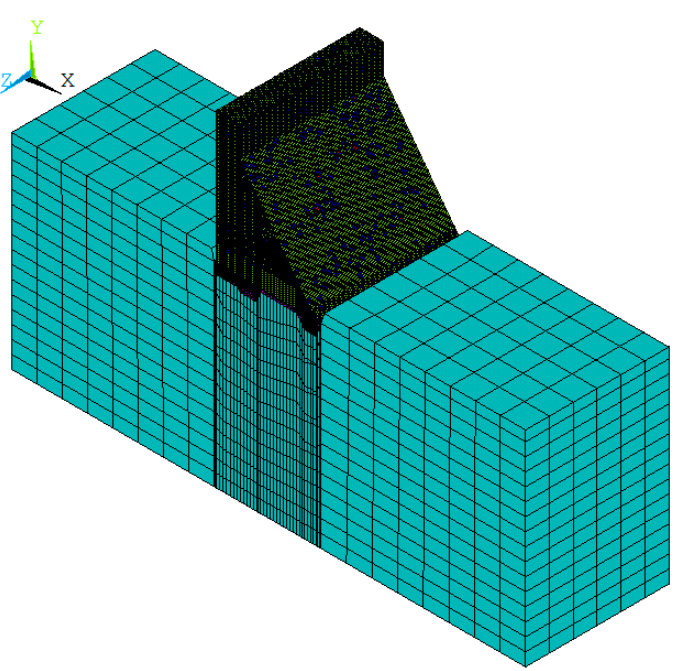
Figure 8. Overall finite element model of the dam in the macro–meso scale.